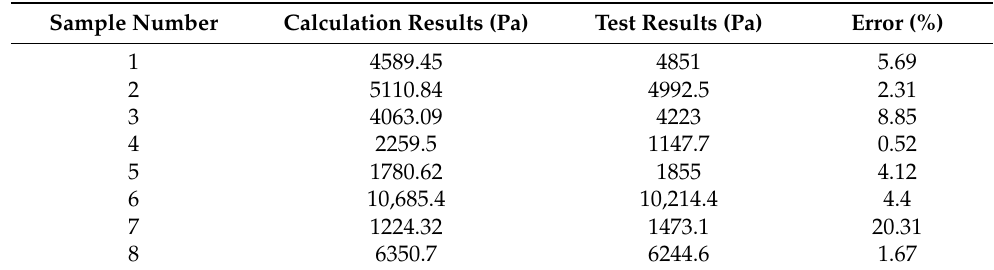
Table 7. Comparison between the test results of the flow channel samples and the calculation results of the mathematical model.